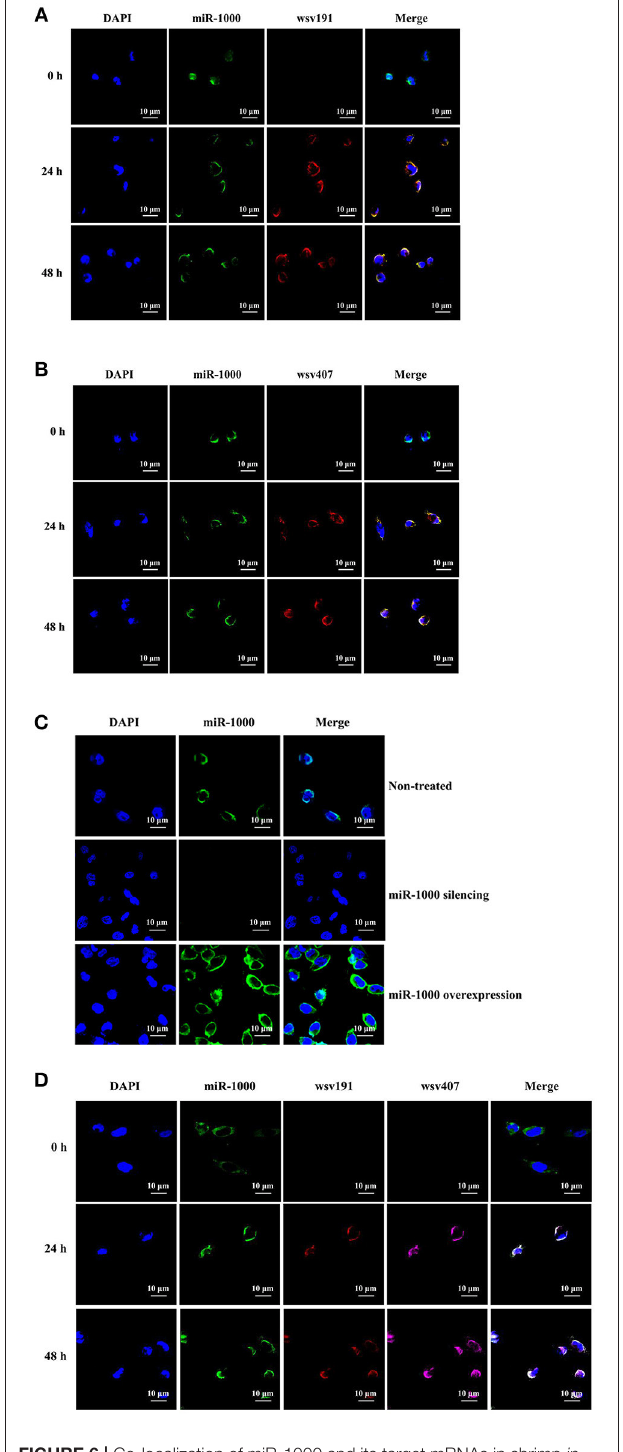
FIGURE 6 | Co-localization of miR-1000 and its target mRNAs in shrimp in vivo . (A) Co-localization of miR-1000 and wsv191 mRNA in shrimp hemocytes. Shrimp were infected with WSSV. At different time points post-infection, miR-1000, wsv191 mRNA, and nuclei of hemocytes were respectively detected with FAM-labeled miR-1000 probe (green), Cy3-labeled